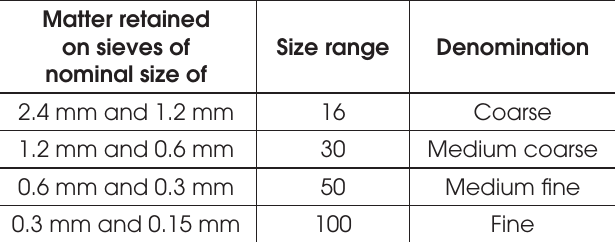
Grain size fractions of regular sand Matter retained on sieves of nominal size of